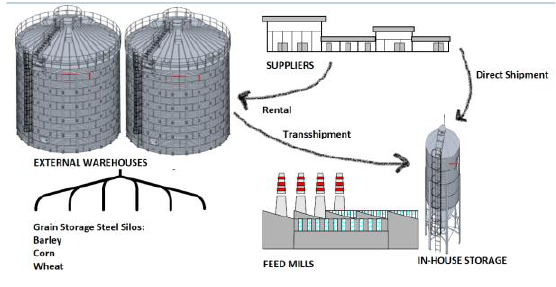
Figure 1. Supply chain